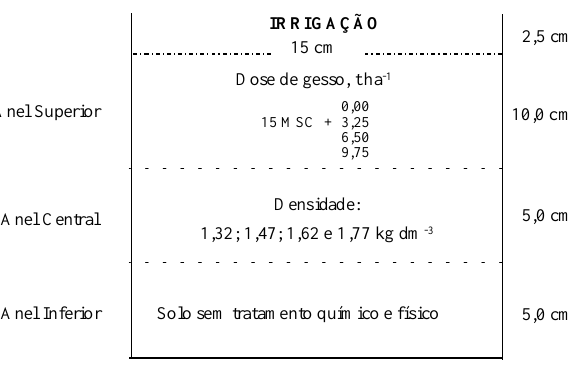
Figura 1. Esquema da coluna formada pela sobrepo- sição de três anéis de